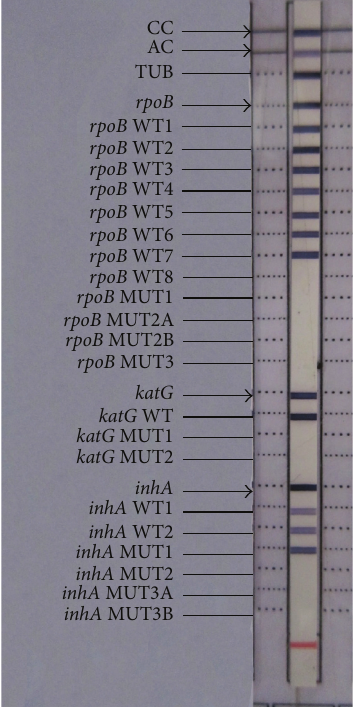
Figure 2: Patient with MDR TB showing presence of rpoB MUT3 band and inhA MUT1 band along with the wild type bands indicat- ing rifampicin resistance and INH heteroresistance, respectively.